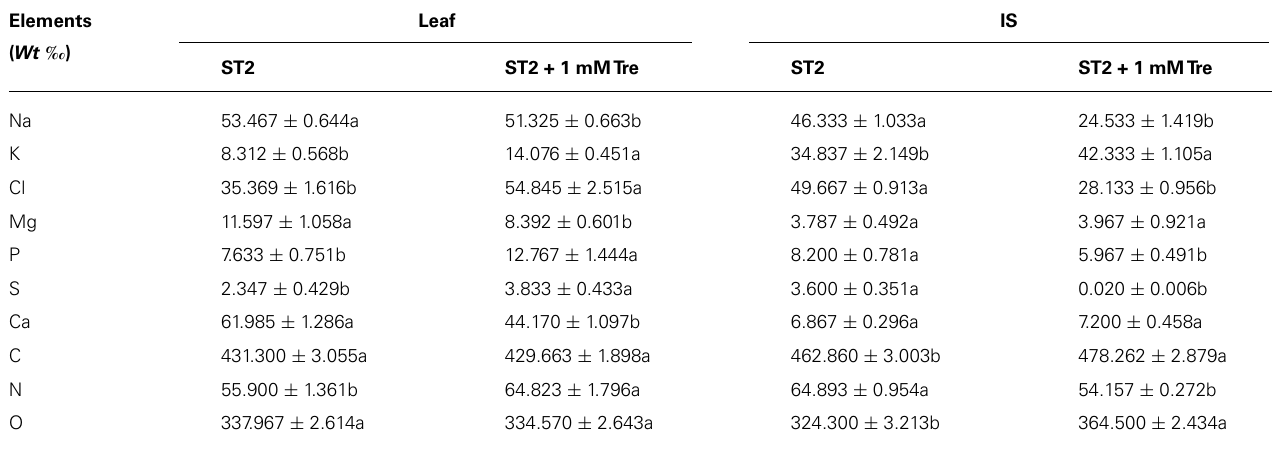
Table 2 | Element variations in leaf and inflorescence stem (IS) of Arabidopsis plants treated with 250 mM NaCl (ST2) in presence of 0 or 1 mM Tre.